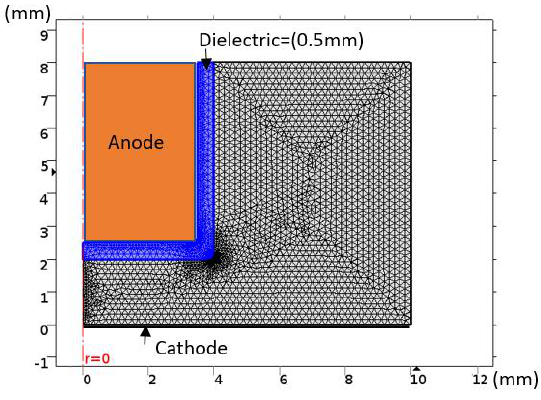
Figure 2. Computational domain of simulation.